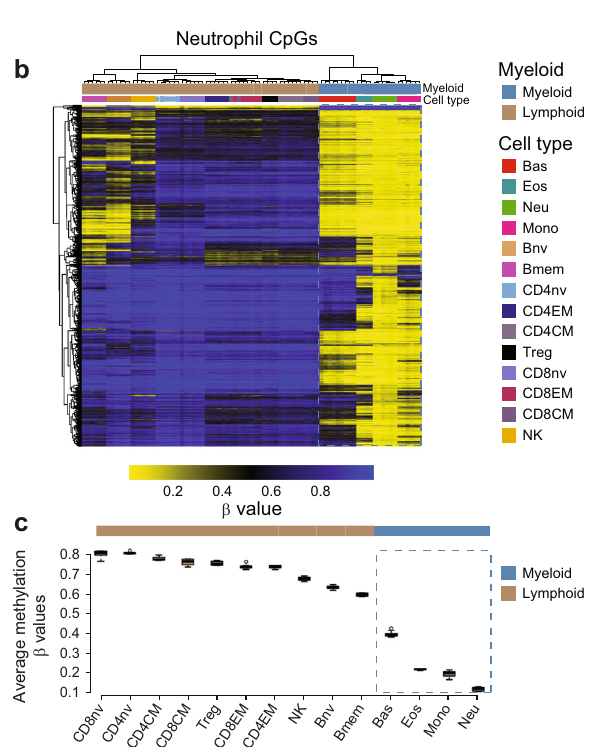
Fig. 1 | Study design and results. a There were four phases to the design. First, in Biomarker Discovery two pipelines (EWAS/CellDMC (see b ) and immune cell deconvolution) were applied to a cohort of 135 immune pro fi le study (IPS) glioma cases of which 59 were DEX exposed and 76 were not. Second, three different elastic net regression models (DEX Exposure Predictors) were built using different CpGs(Non-cell-speci fi c(1stmodel)andNeutrophilspeci fi c(NDMI:2ndmodel))and 5 immune parameters (3rd model) on the same 135 IPS glioma cases. Third, the three models were evaluated by anindependent cohort of 552 AdultGlioma Study